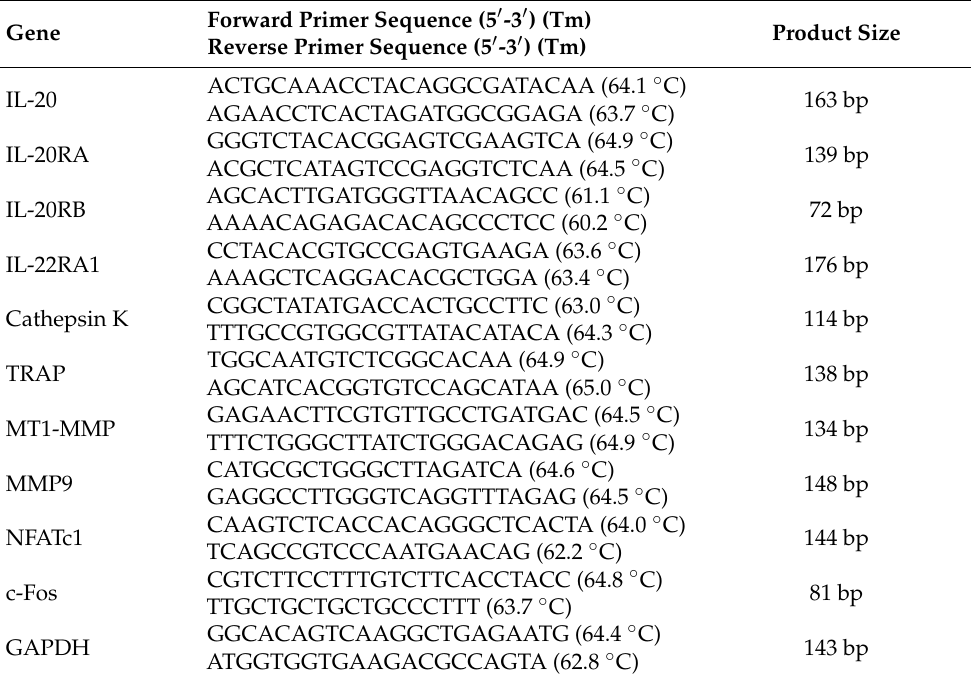
Table 1. Primers sequences used for real-time PCR.